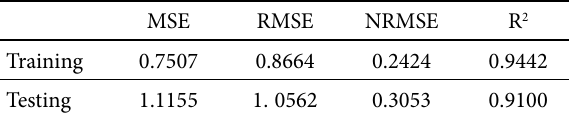
Table 7. The performance of final SVR model (scenario2)